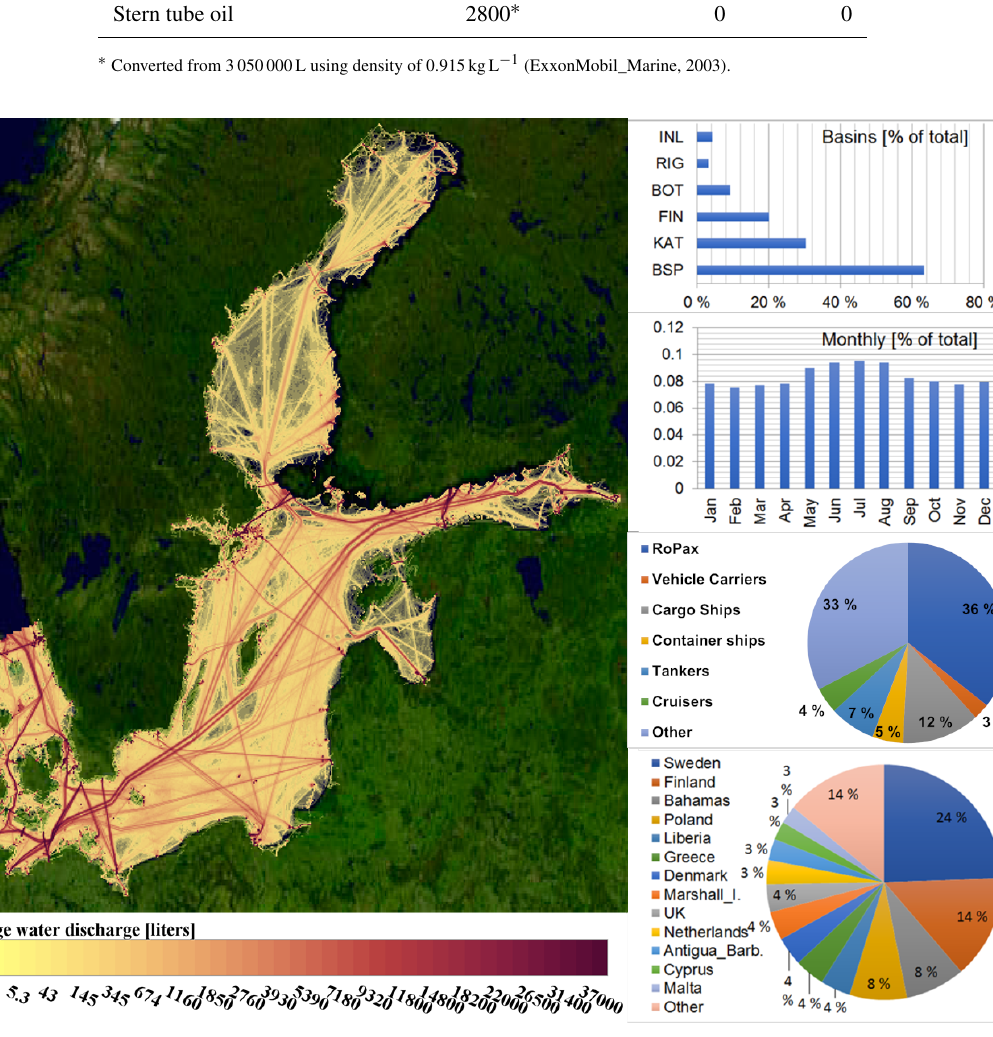
Figure 3. Distribution of the annual bilge water releases for the year 2012 from the Baltic Sea shipping. Discharge volumes are indicated per map grid area of 5km 2 . Note that release of bilge water is prohibited within 4nm from the Finnish coastline. Top right: share of bilge water released in various sub-basins of the Baltic Sea (INL: inland areas; RIG: Gulf of Riga; BOT: Bothnian Bay and Bothnian Sea; FIN: Gulf of Finland; KAT: Kattegat; BSP: Baltic Sea proper). The lower bar chart depicts the monthly variation in bilge water discharges. The upper pie chart summarises the contribution of various ship types to bilge water releases and the lower pie chart the flag state shares of bilge water releases. Map: background Landsat-8 image courtesy of the U.S. Geological